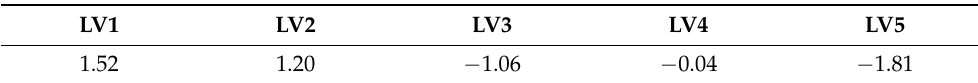
Table 3. Standard error of prediction (SEP) for each of the five latent variables derived from the N-PLS model on the calibration set.